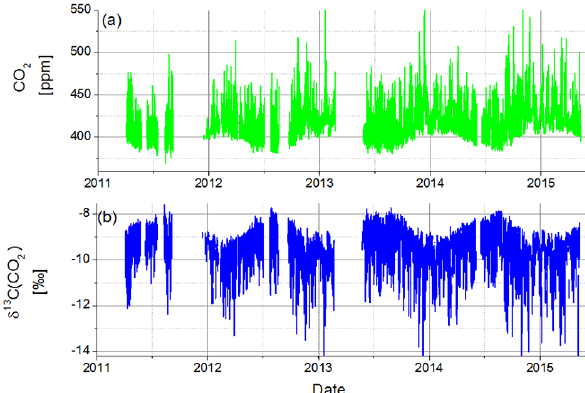
Figure B1. Continuous Heidelberg hourly FTIR record of (a) CO 2 and (b) δ 13 C(CO 2 ) from April 2011 to June 2015. Data gaps occur when the instrument was away during a measurement campaign or when instrumental problems